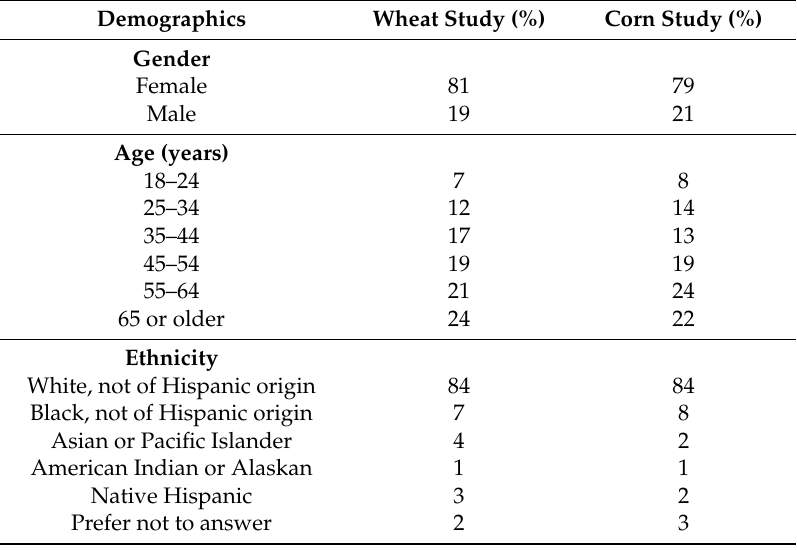
Table 3. Demographic information of participants of the online surveys (per study, n = 300).